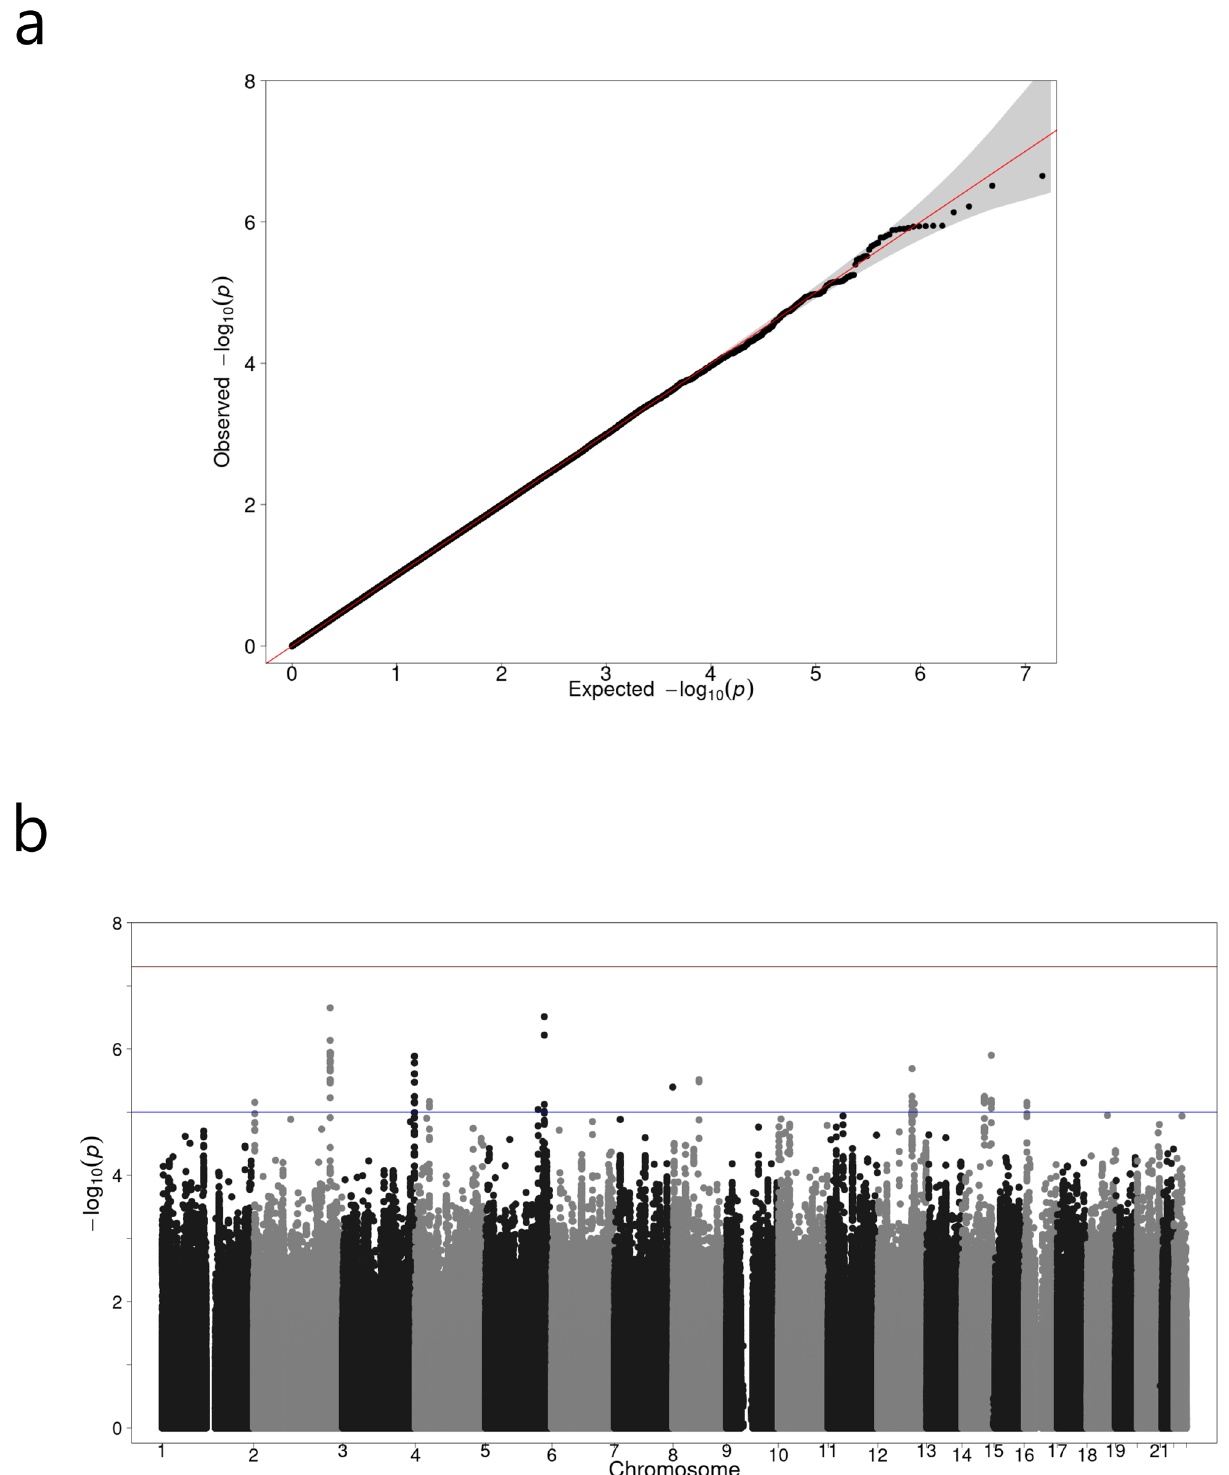
Figure 1. ( a ) Quantile–quantile and ( b ) Manhattan plots of the meta-analysis results of the GWAS in the FinnDiane-cohort and DIREVA-cohort. In ( b ) two horizontal lines indicate P value thresholds for suggestive significance (P < 10 –5 ) and genome-wide significance (P < 5 × 10 –8